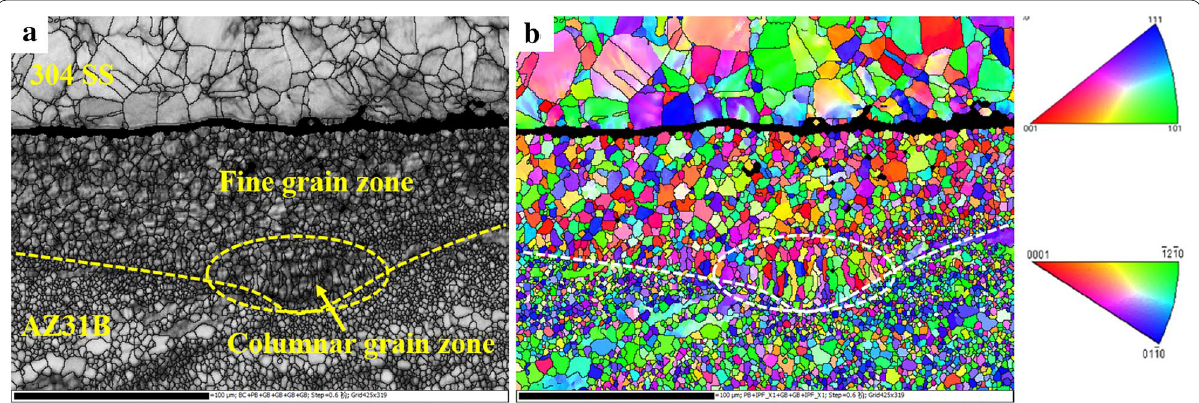
Figure 8 Microstructure of the 304SS/Mg composite joint: ( a ) band contrast (BC) map and ( b ) inverse pole figure (IPF)